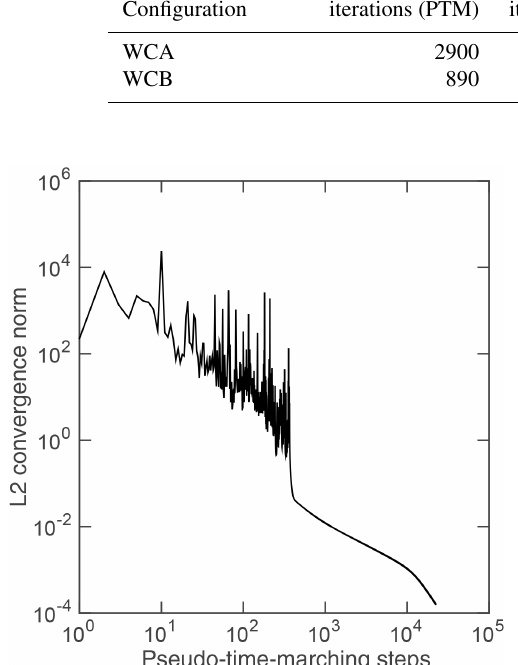
Figure 5. Convergence of the L2 norm between consecutive pseudo time-marching solutions for the PTM with configuration B of the San Antonio and Guadalupe river network. Note the above figure uses the number of time-marching steps as compared to the larger number of Newton iterations provided in Table